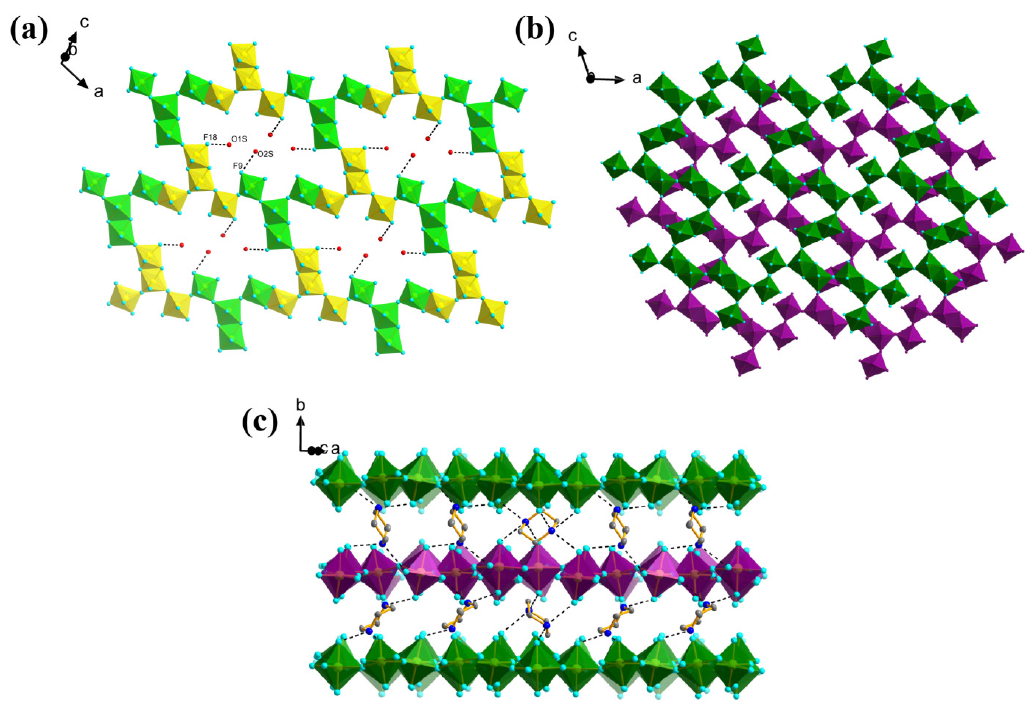
Figure 4. ( a ) The 2D layers with channel water molecules of 1 . The octahedra with different colours show how the “Y” shaped Fe-F building units are connected. (Hydrogen bonds are depicted by dotted lines); ( b ) Plan view of the layer stacking, with different layers shown in different colours. (H 2 pipz and water molecules are eliminated for clarity); ( c ) The stacking of the layers with H 2 pipz along the b -axis (Selected hydrogen atoms are eliminated for clarity but hydrogen bonds are depicted by dotted